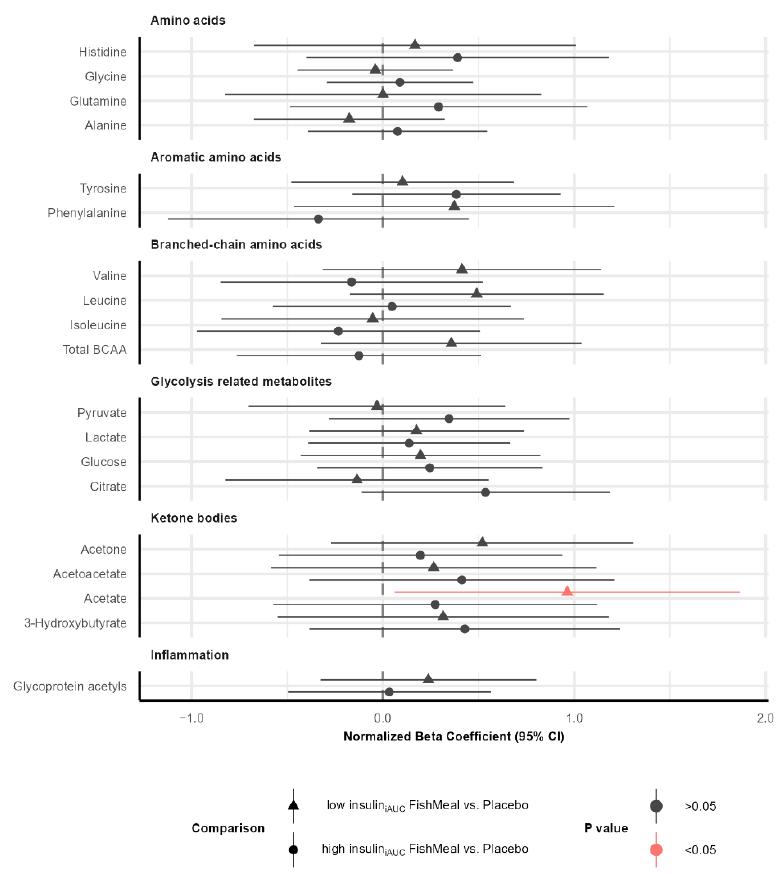
Figure 4. Changes in amino acids, glycolysis-related metabolites, ketone bodies, and inflammation markers concentration in plasma after the intervention. The forest plot displays the normalized beta coefficients (mean difference) and 95% confidence interval for the differences between the fish protein-treated low insulin iAUC group and placebo-treated low insulin iAUC group (triangles) and the differences between the fish protein-treated high insulin iAUC group and placebo-treated high insulin iAUC group (circles). Estimates on the left and right side of the zero-line translate to lower and higher in individuals that received the fish protein than those that received the placebo, respectively. Color denotes the p value. Abbreviations: BCAA: Branched-chain amino acids, iAUC: incremental Area Under the Curve.